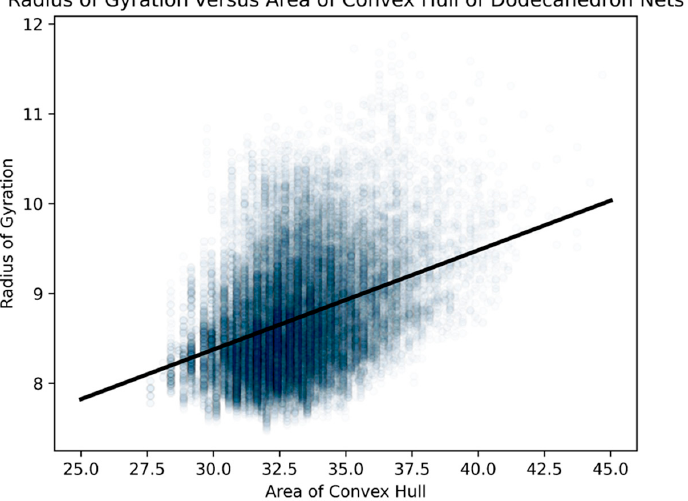
Figure 23. For all 43,380 Dürer nets of dodecahedra, we did a scatterplot of the areas of their respective convex hulls with their respective radii of gyration. We standardized the length of an edge of a pentagonal face of a dodecahedron at “1”. The R2 value was 0.142 and the probability of being due to randomness was less than 10 − 6 .